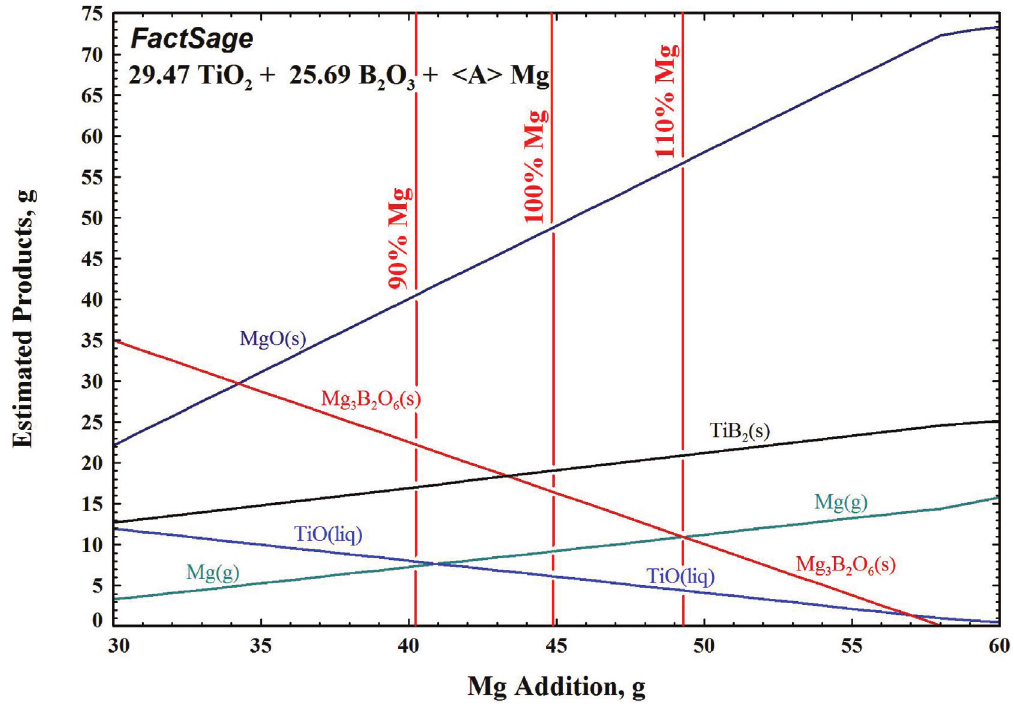
Fig. 1: Effects of increasing Mg reductant amount on the composition of SHS